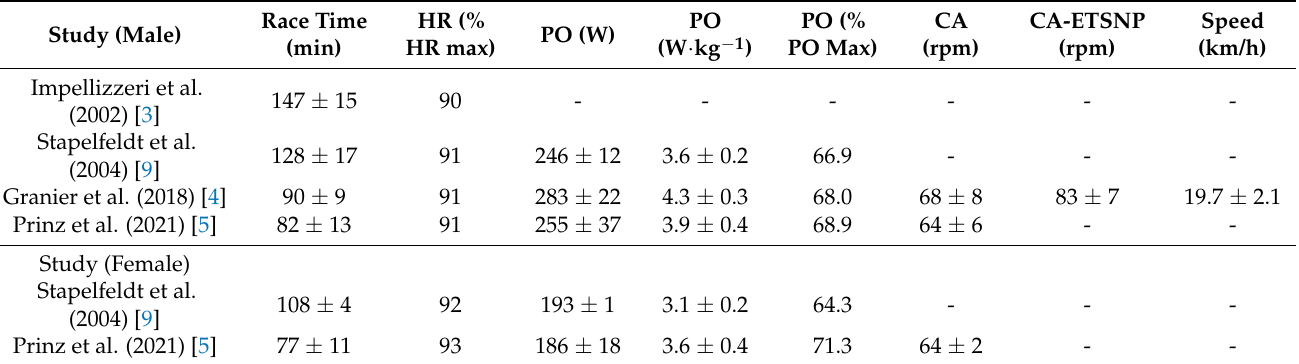
Table 2. Race time, physiological responses and mechanical demands to XCO competition obtained from published studies in English on the